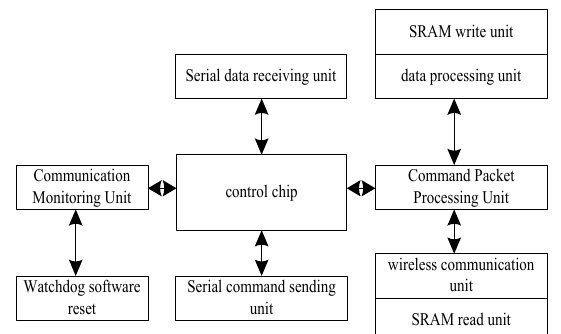
Figure 2. Wireless node module structure